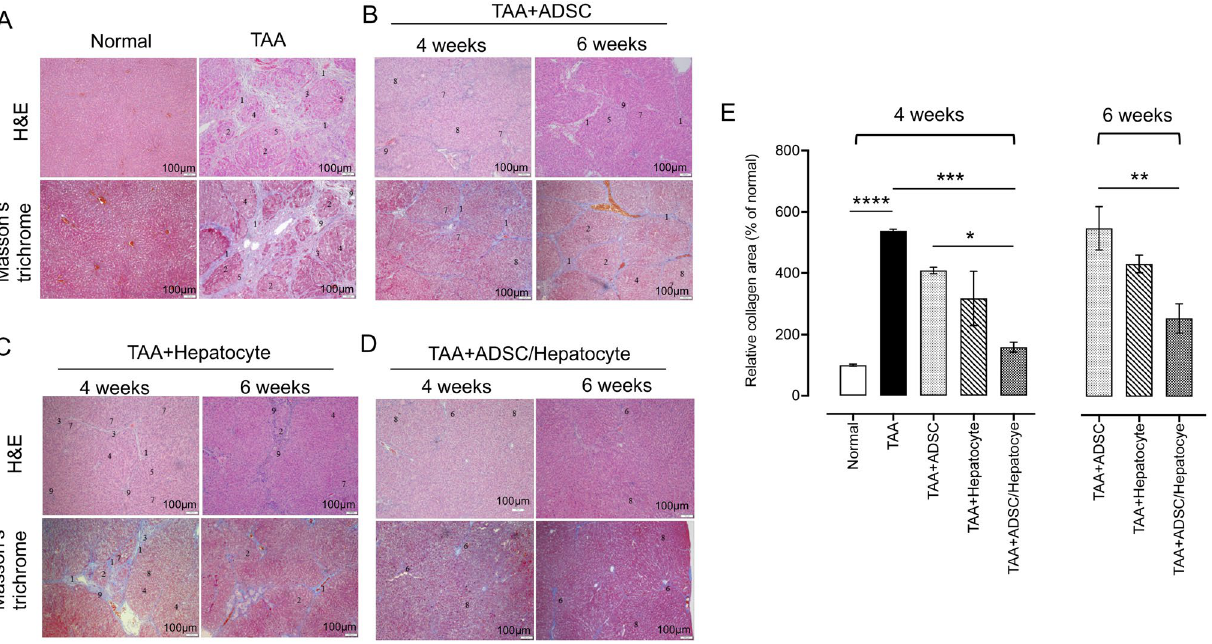
Figure 4. Histological analysis of thioacetamide (TAA)-induced liver cirrhosis in the various experimental groups. ( A ) In rats with TAA-induced liver cirrhosis (n = 3), the severe fibrotic pathological features were observed by hematoxylin and eosin (H&E) and Masson’s trichrome staining. ( B – D ) In rats treated with ADSC, hepatocyte or hybrid ADSC/hepatocyte, spheroids reveal a beneficial effect on alleviating the severe fibrotic pathological features in TAA-induced liver cirrhosis. Scale bar: 100 μm. ( E ) Quantitative analysis of the amount of collagen stained by Masson’s trichrome in each group. The description of pathological features: (1) reticular fibers circumscribing the nodules; (2) obvious formation of pseudolobules; (3) numerous fibrocytes; (4) hepatocyte necrosis; (5) swollen hepatocytes; (6) large/moderate decreases in fibrous tissues/fibrocytes; (7) proliferation of the mini-bile duct; (8) fatty degeneration-like areas; (9) inflammatory cell infiltration. Group data are shown as means ± SEM. Statistical analysis was undertaken with One-way ANOVA; * P < 0.05; **, P < 0.01; ***, P < 0.001, ****, P <